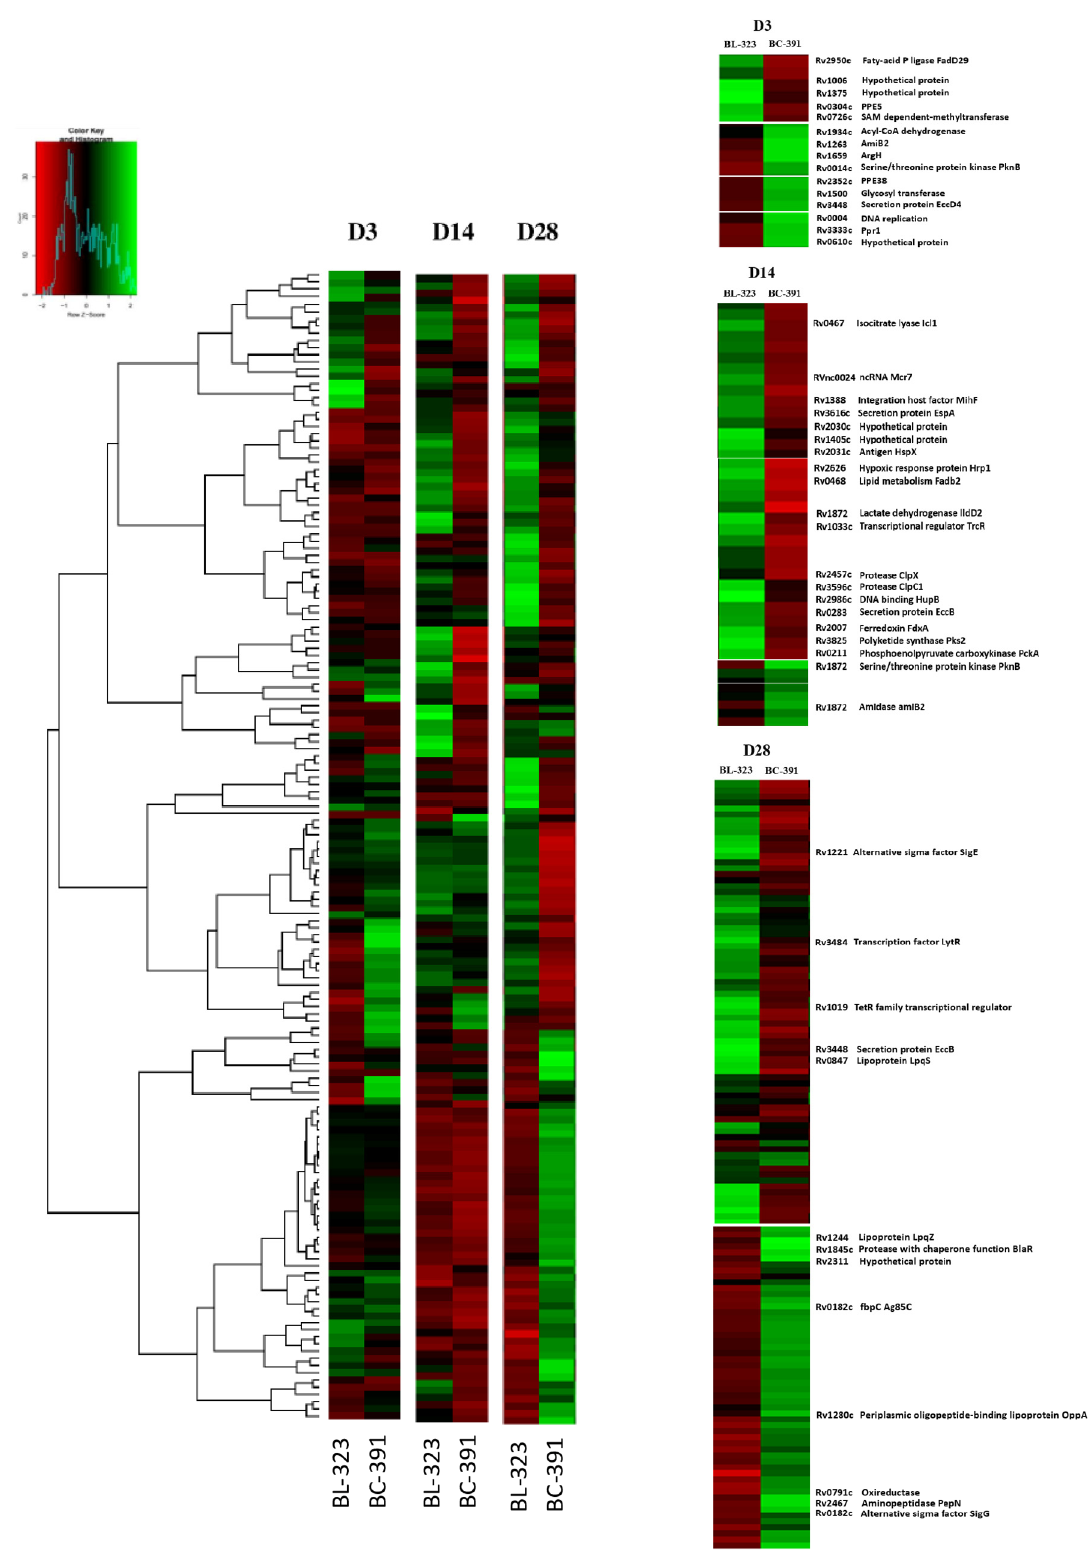
Figure 5. Comparative heatmap between strain BL-323 and BC-391 at each day of the analysis. The figure was edited to show the relevant